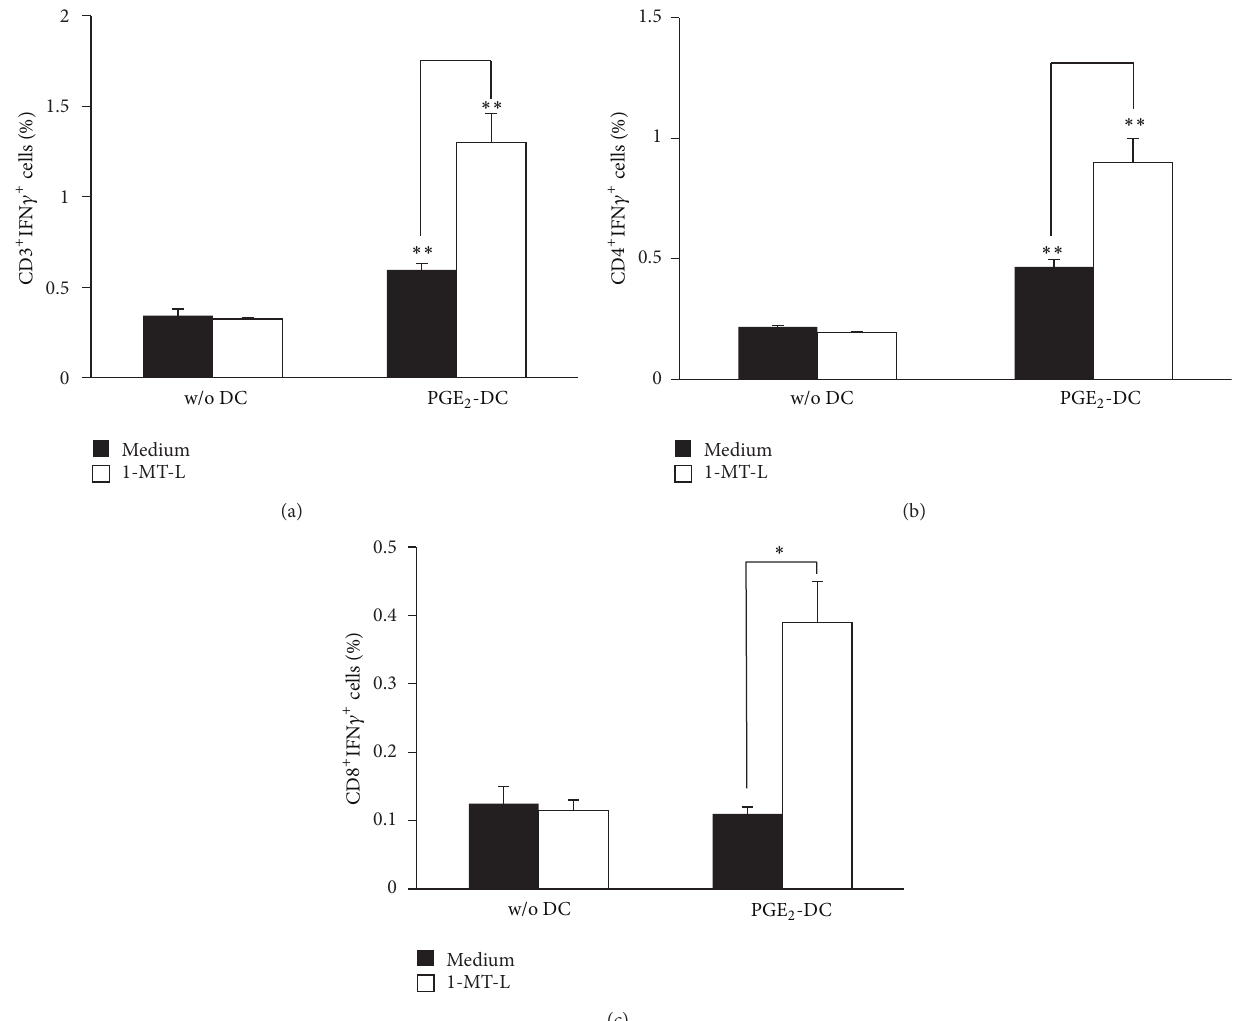
Figure 4: IDO1 expression inhibited leukemia-specific IFN- 𝛾 production. AML cells were lysed and used for the pulsing of immature Mo- DCs. Mo-DCs were subsequently matured with the cytokine cocktail containing PGE 2 . Autologous CD3 + T cells were cocultured with the preloaded and matured DCs for an overnight, in the presence or absence of the IDO1-specific inhibitor 1-MT-L. As control samples, unloaded Mo-DCs were used (data not shown). (a) CD3 + T cells, (b) CD4 + T cells, and (c) CD8 + T cells were tested for leukemia-specific intracellular IFN- 𝛾 production. Results are expressed as the mean ± SEM of 3 independent experiments. ∗ 𝑃 < 0.05 , ∗∗ 𝑃 < 0.01 versus w/o DCs or versus medium